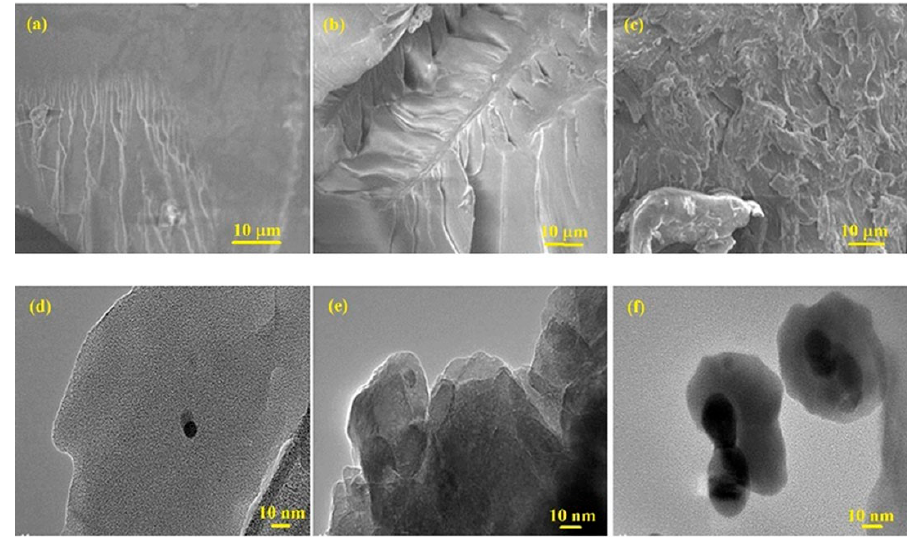
Figure 8. SEM and HRTEM micrographs of ( a , d ) PS–AgNPs; ( b , e ) PMMA–AgNPs; and ( c , f ) PS–